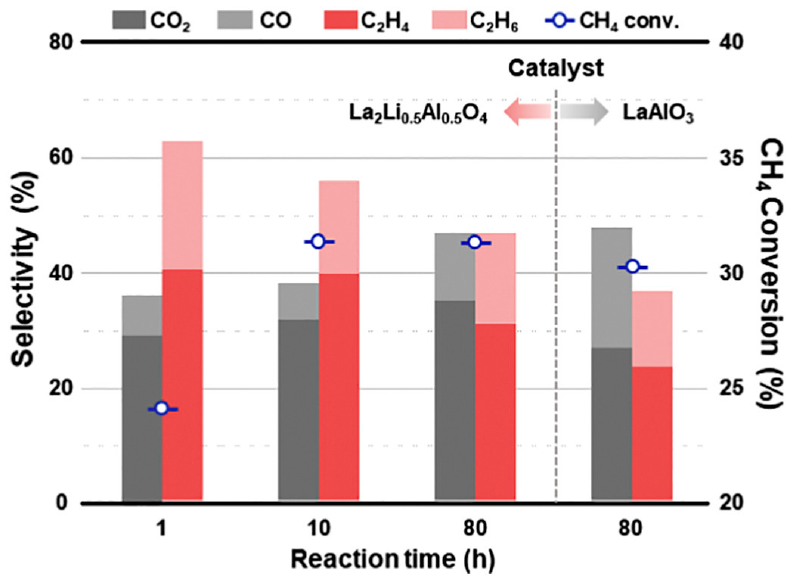
Figure 28. Catalytic activities of the La 2 Li 0.5 Al 0.5 O 4 and LaAlO 3 OCM catalysts (Reprinted with permission from [123]).